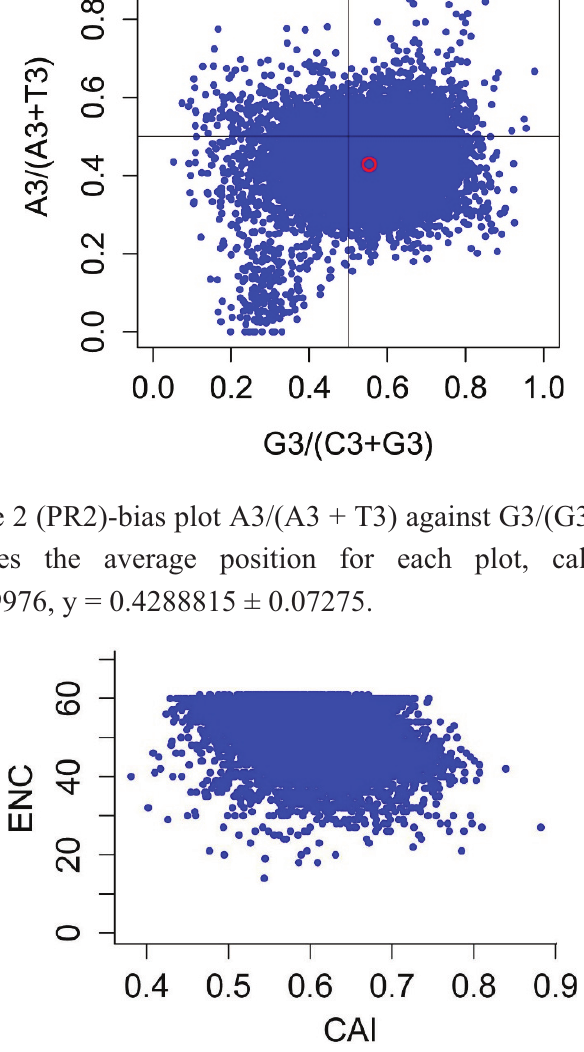
Figure 8. Plot of ENC vs . gene expression level for P . lactiflora